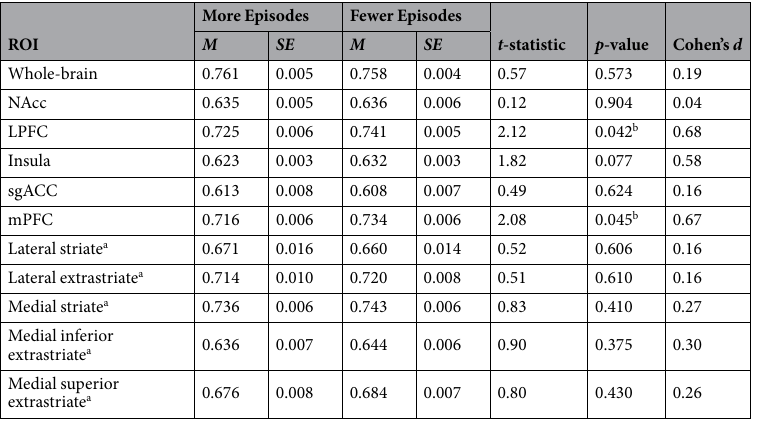
Table 3. R1 and the number of depressive episodes of Major Depressive Disorder. Median split was used to create two groups of MDD participants based on the number of prior depressive episodes. The more episodes group included individuals with 6 or more episodes ( N = 17), and the fewer group 5 or less episodes ( N = 22). ROI = region of interest; M = mean; SE = standard error; NAcc = nucleus accumbens; LPFC = lateral prefrontal cortex; sgACC = subgenual anterior cingulate cortex; mPFC = medial prefrontal cortex; a = visual network control regions; b = significant at p <